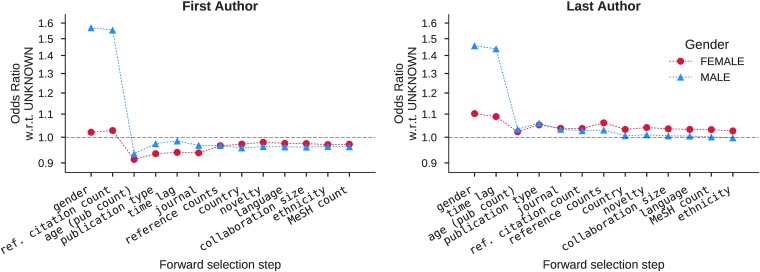
Change in effect of gender at each model-fitting step.The sub-figures show the contribution of gender at each step in the iterative process of fitting and evaluating combinations of factors; only the model at the final step is the best-fitting among them. In both models, confounding factors ultimately minimize the effect of gender in self-citation; the most influential of them is author’s publication count (note Table 6). Y-axis is on log scale.